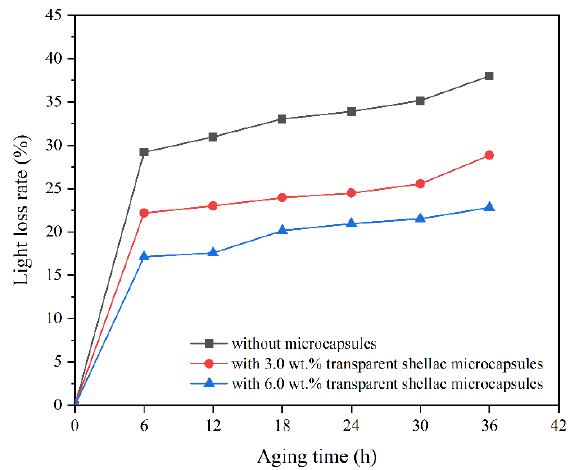
Figure 11. The Δ E* of the coating on Beli wood with yellow shellac microcapsules after aging. Figure 11. The ∆ E* of the coating on Beli wood with yellow shellac microcapsules after aging.